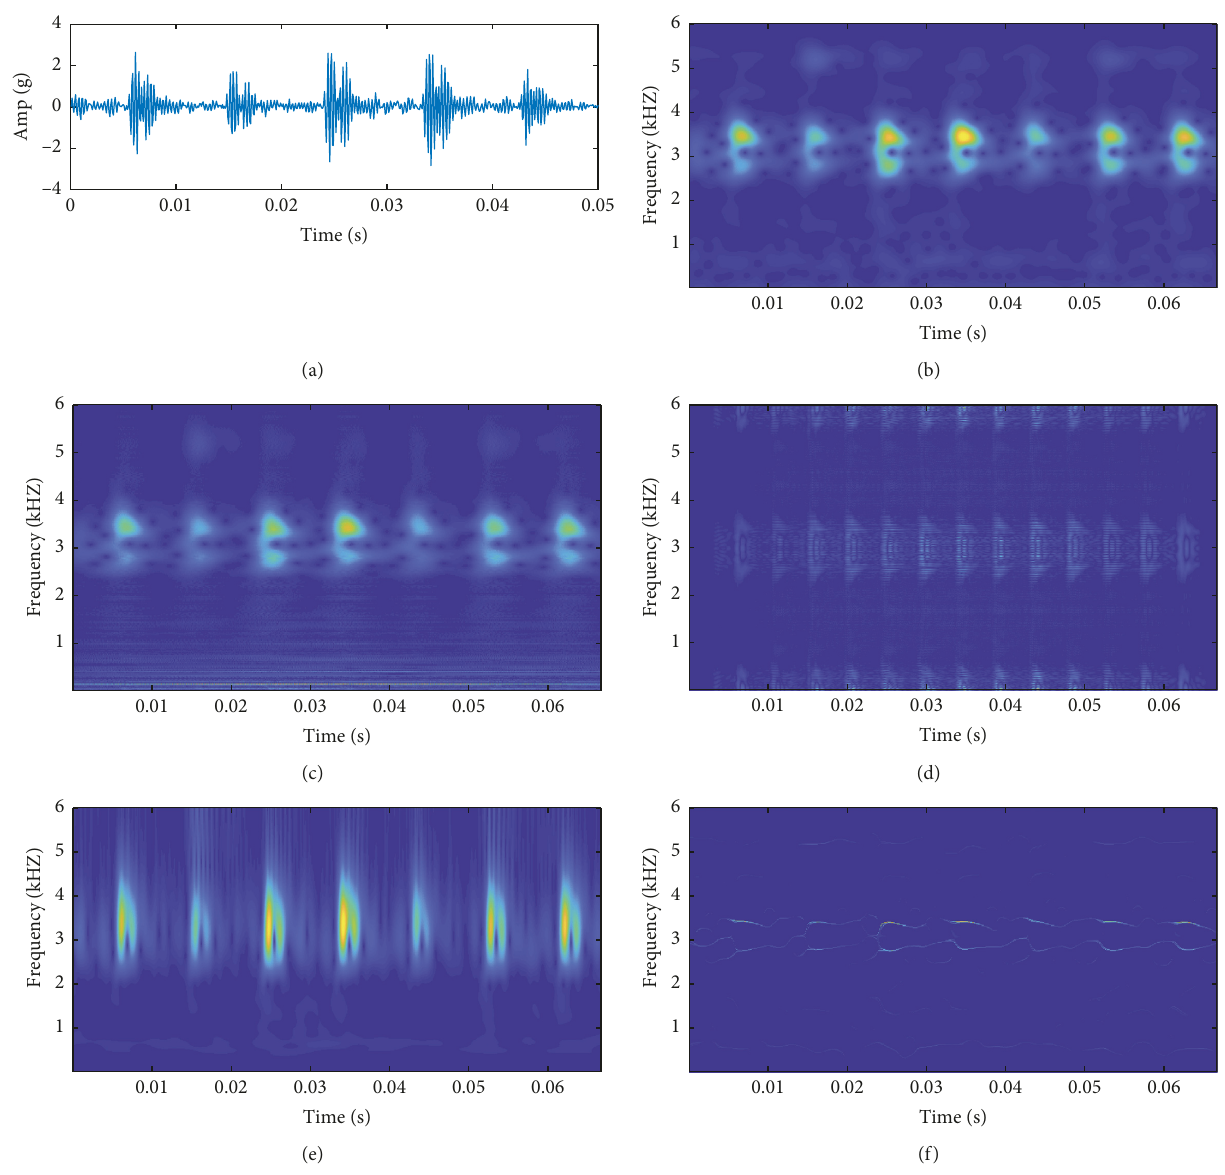
Figure 2: Time-frequency representations of different methods: (a) actual signal; (b) STFT; (c) CWT; (d) WVD; (e) ST; (f)